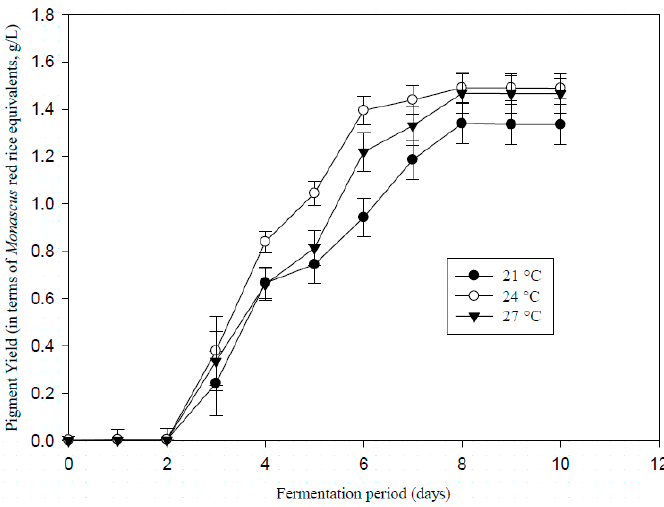
Figure 2. Compared effects of culture at three different temperatures (21, 24, and 27 ◦ C) on red pigment yield (expressed in Monascus red rice equivalents g/L, measured at 500 nm) for T. albobiverticillius 30548 (culture in PDB, initial pH 4.0, 200 rpm of agitation rate).